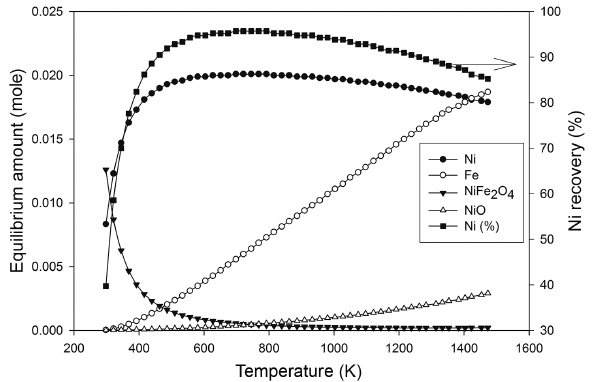
Figure 3: Effect of temperature on the amounts of the nickel- containing species, the nickel recovery and the amount of metallic iron for reduction of the ore in hydrogen at a reductant to ore ratio of 0.558 kmol/100